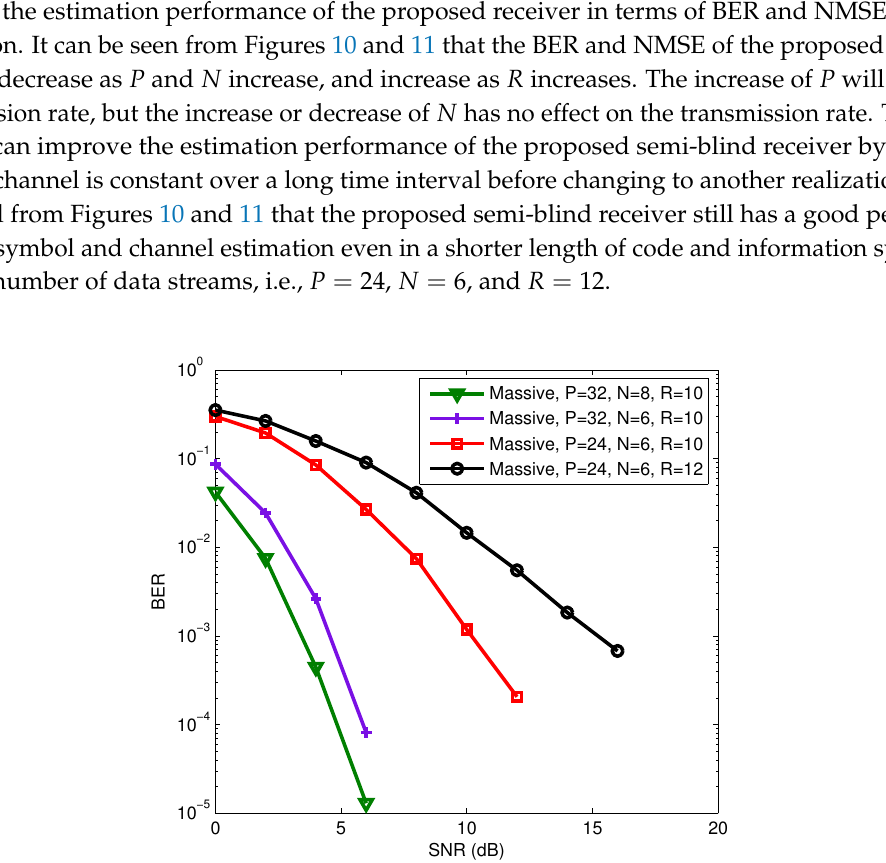
Figure 10. BER performance of the proposed receiver for the multi-user massive multiple-input multiple-output (MIMO) system.